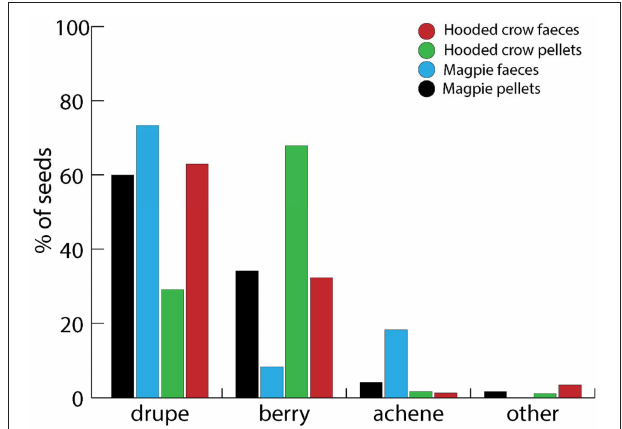
FIGURE 4 | Relative abundance of different fruit types (Baseflor, Julve, 1998) among intact seeds recovered from pellet and fecal samples of Magpies and Hooded Crows by Heintze. Fleshy fruits are drupes, berries and three species with fleshy achenes (such as dog rose, Rosa canina ). “Other” includes small